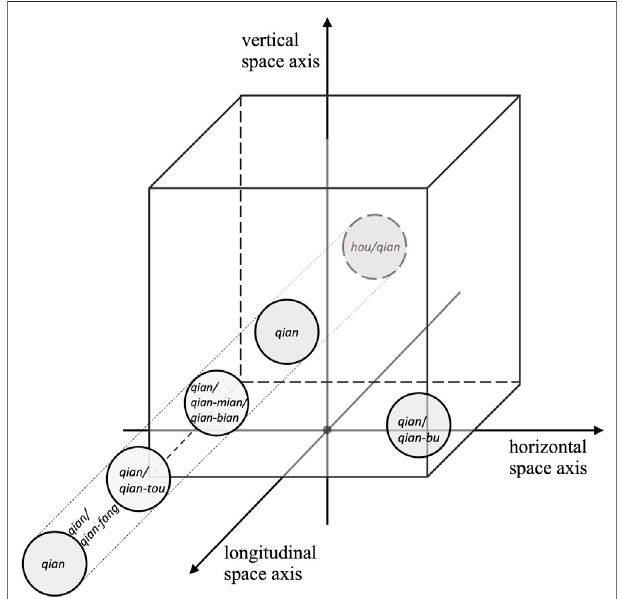
FIGURE 5 | The semantic map for qian . The map represents qian ’ s more restricted polysemy. This simple localiser can refer to the “ intrinsic front ” of a groundorits “ relativefront ” (i.e.,aground ’ s “ back ” ,thusoverlappingwith hou in reference). It can also refer to the (external) “ front side ” of a ground, althoughthecompound localisers qian-mian and qian-bian canonlyrefer tothis location.Thecompoundlocaliser qian-bu referstoa “ frontpart ” ,i.e., theportion ofa groundthatmay de fi ne the front axis. Weonlymark a portion ofthispartas qian-bu tomaintainthesamesizeforallcircles. Qian-fang referstoa “ frontaxis ” , whenceitspositionisata “ distal ” distancefromtheground.Pre fi xation viazhi- is blocked for this localiser; hence, we do not include them in the map.